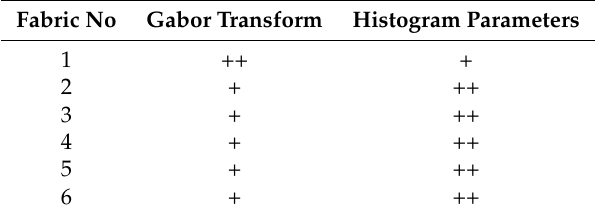
Table 3. Image analysis results—preliminary